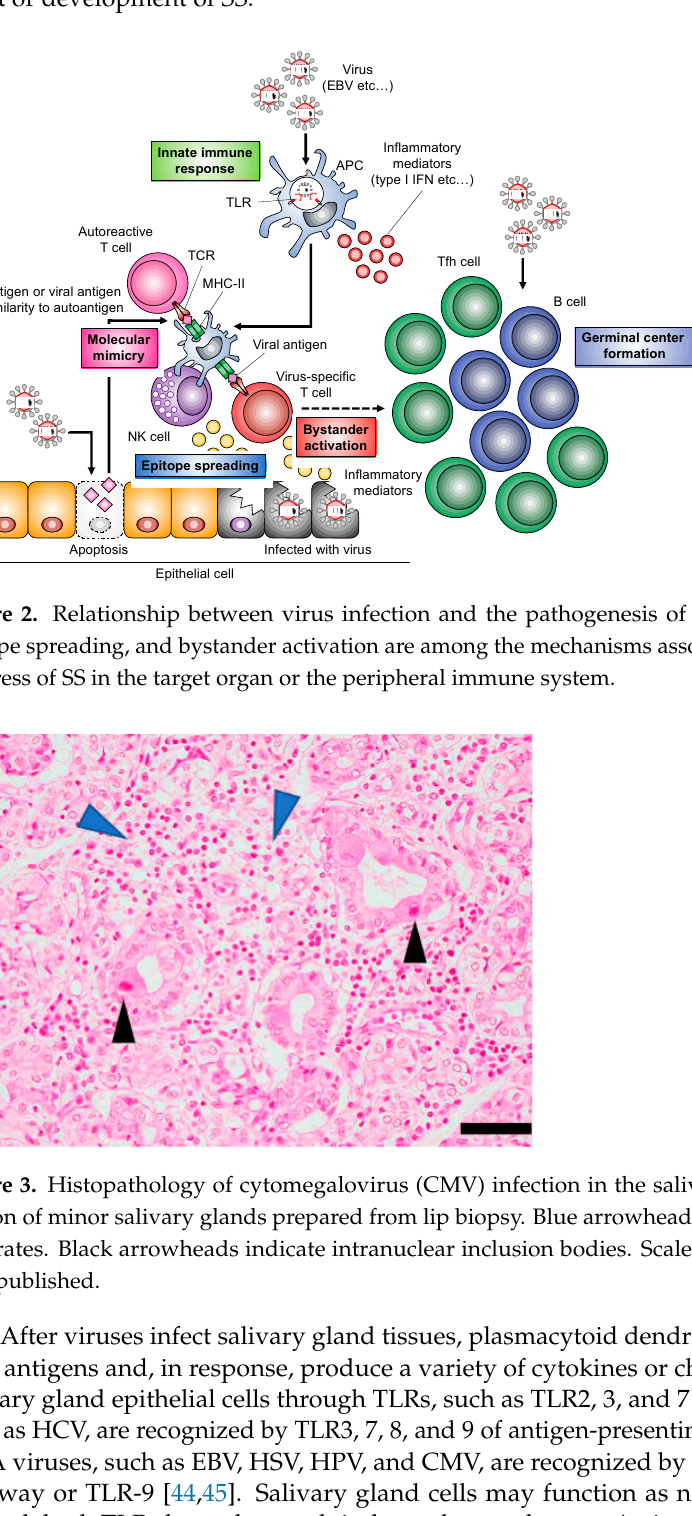
Figure 3. Histopathology of cytomegalovirus (CMV) infection in the salivary gland. HE-stained section of minor salivary glands prepared from lip biopsy. Blue arrowheads indicate inflammatory infiltrates. Black arrowheads indicate intranuclear inclusion bodies. Scale bar: 50 μ m. The image is unpublished.